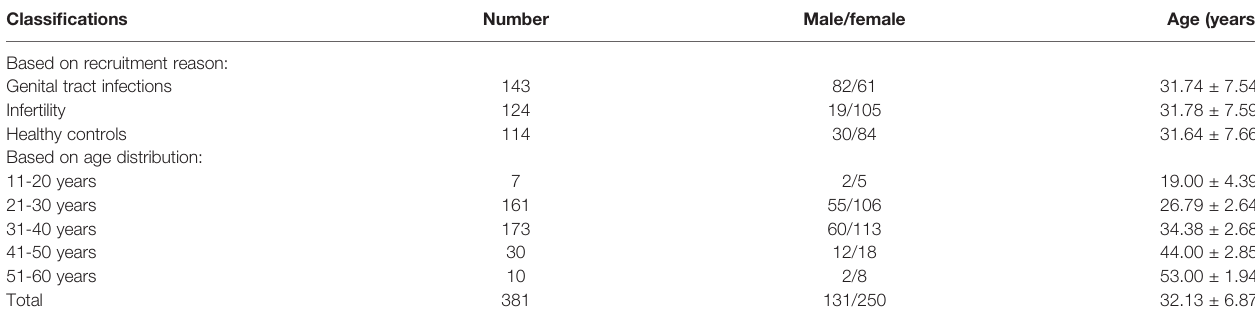
TABLE 2 | The clinical characteristics of the 381 individuals recruited into this study.